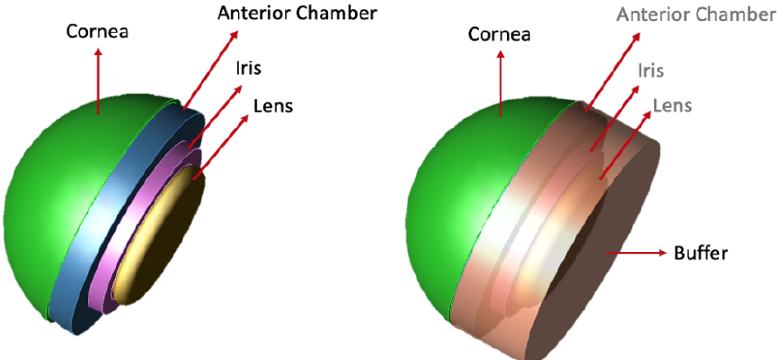
Figure 1. The constructed model of the anterior regions of the human. The model contains the tear film, cornea, anterior chamber (filled with aqueous humor), iris, and lens. The rear of the model contains a buffer cylinder to diffuse any reflected waves.